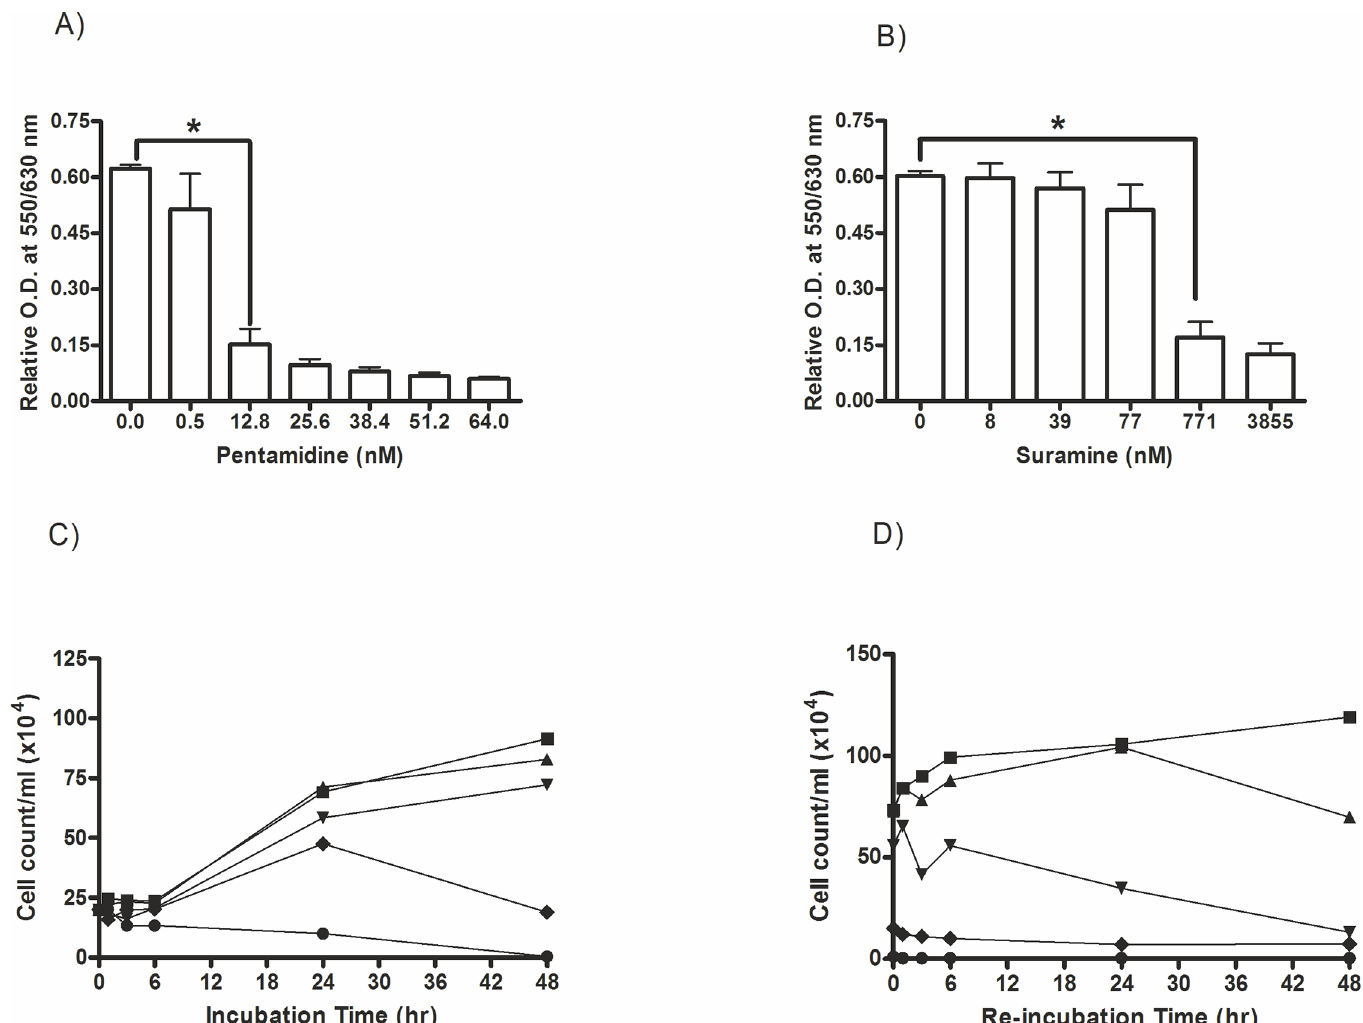
Fig 3. Anti-proliferative effects of pentamidine and suramin on T . brucei . Cell proliferation/viability was assayed as described in Fig 1 with the exception of the use of (A) pentamidine and (B) suramin at variable concentrations. (C) Time dependency of anti-proliferative effects of pentamidine at variable concentrations (12.8 to 128 nM) was performed analogously to the experiments shown in Fig 1. Control samples contained 100 μ l of fresh medium instead of a trypanocidal compound. Pentamidine concentrations used were: 0 nM ( ■ ), 12.8 nM ( ▲ ), 51.2 nM ( ▼ ), 64 nM ( ♦ ) and 128 nM ( ● ). (D) Recovery test of T . brucei cells exposed to pentamidine was done in 24-well in the presence of pentamidine (12.8 nM to 128 nM). Pentamidine concentrations used were: 0 nM ( ■ ), 12.8 nM ( ▲ ), 51.2 nM ( ▼ ), 64 nM ( ♦ ) and 128 nM ( ● ).The results depict the mean of three independent measurements (n = 3), * p < 0.05.